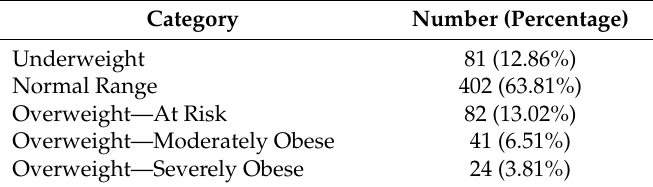
Table 5. BMI distribution.